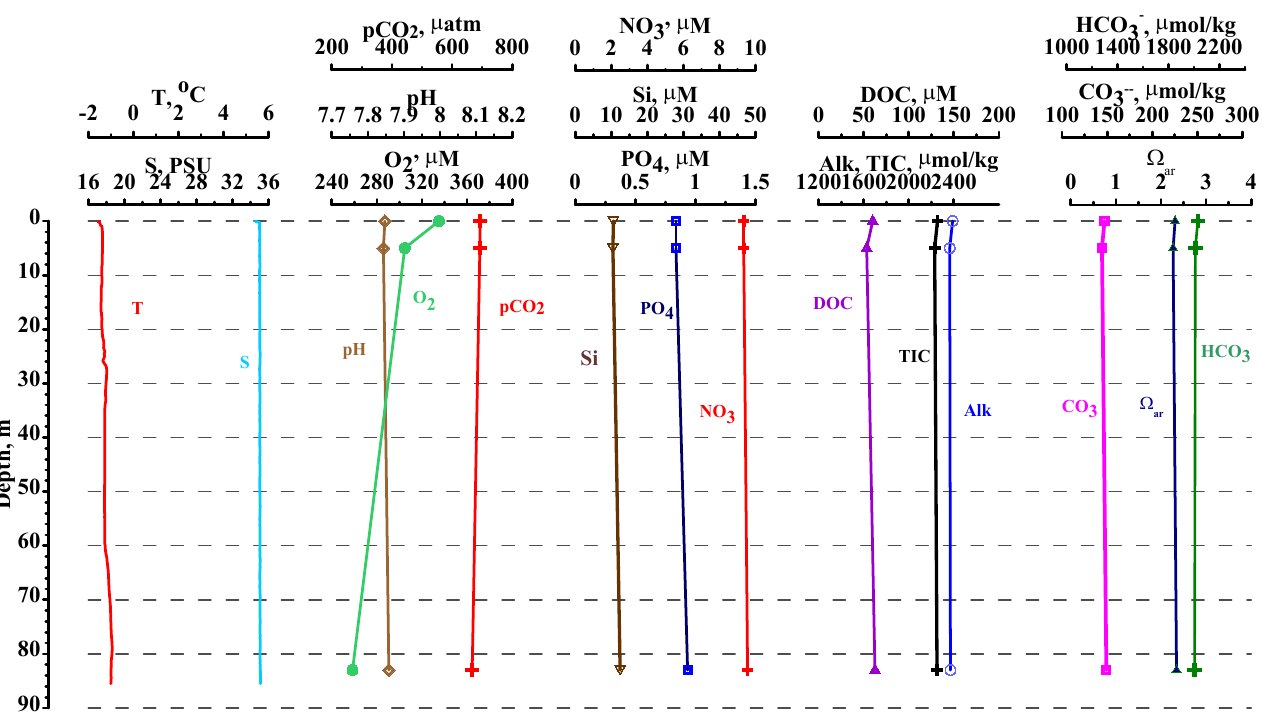
Figure A5. Vertical distribution of physical and chemical parameters at station TM4 (19 March 2014).